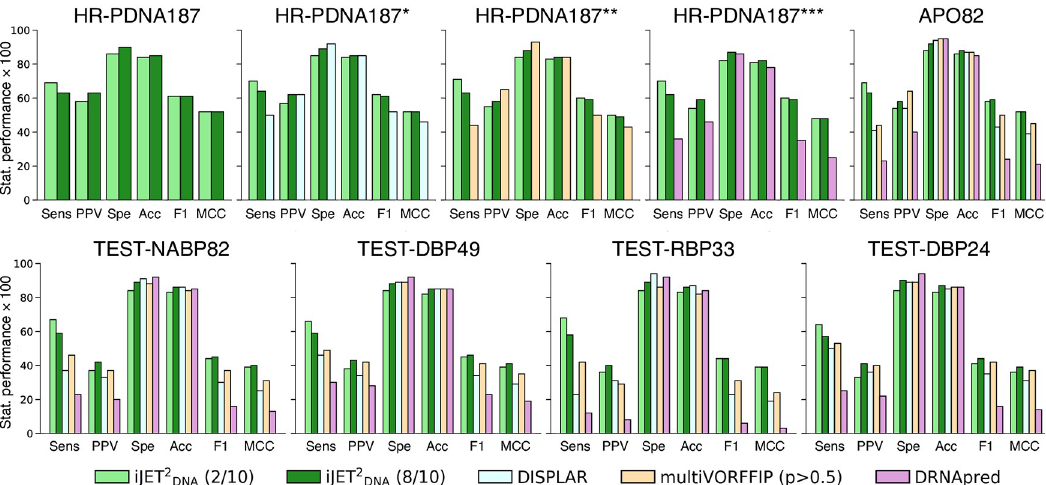
Fig 4. Comparison of iJET 2 , DISPLAR, multiVORFFIP and DRNApred performance. For iJET 2 , consensus predictions DNA DNA were obtained from 2 (in light green) and 8 (in dark green) runs out of 10. Statistical performance values are given in percentages. Top panel . HR-PDNA187 and APO82. To fairly assess DISPLAR, multiVORFFIP and DRNAPred performances, the proteins used for training these methods were removed from HR-PDNA187. We used a sequence identity cutoff of 95% and ended up with 106 ( � ), 87 ( �� ) and 42 ( ��� ) proteins, respectively. Bottom panel . TEST-NABP82 and its subsets. TEST-DBP49 and TEST-DBP24 contain only DNA-binding sites, while TEST-RBP33 contains only RNA-binding sites. TEST-DBP24 and TEST-RBP33 contain only proteins sharing less than 30% sequence identity with proteins from HR-PDNA187 (see Materials and methods). DRNApred and multiVORFFIP were evaluated on their RNA-specific algorithms for the RNA-binding proteins, and on their DNA-specific ones for the DNA-binding proteins. iJET 2 and DISPLAR, which do not have a specific algorithm to predict RNA-binding sites, were DNA evaluated on the same algorithm for both DNA- and RNA-binding proteins.